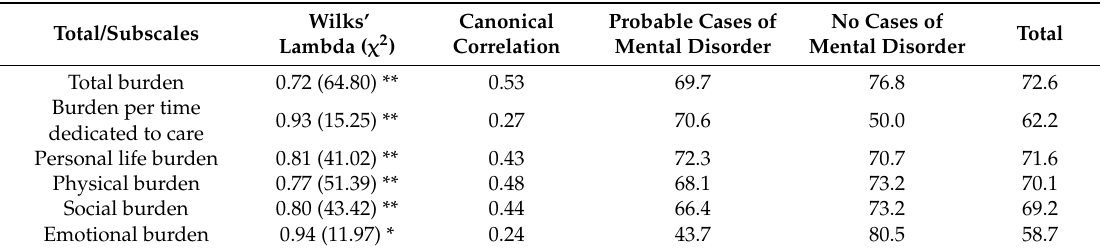
Table 3. Discriminant analysis and percentage of cases correctly classified of the original CBI.